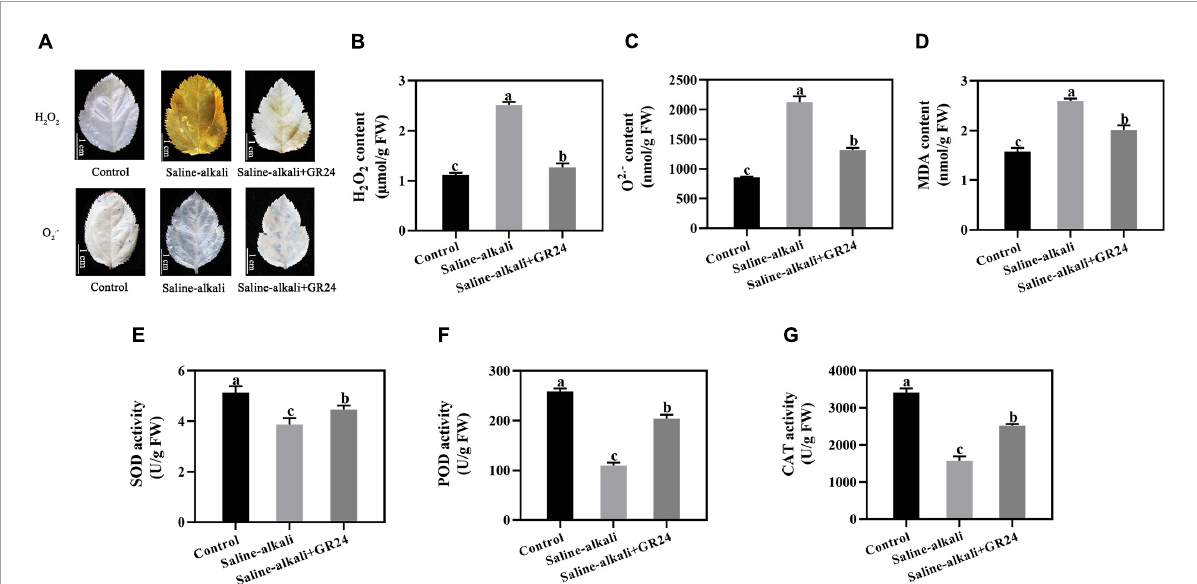
FIGURE3 Effects of GR24 treatment on H 2 O 2 , O 2 - (A) , and H 2 O 2 content (B) , O 2 · - content (C) , malondialdehyde (MDA) content (D) , superoxide dismutase (SOD) activity (E) , peroxidase (POD) activity (F) , and catalase (CAT) activity (G) under salinity-alkalinity stress. The bar (A) represents 1.0 cm. The data represent the mean ± SD of three biological replicates. Different lowercase letters indicate significant differences according to Fisher’s least significant difference ( P < 0.05).